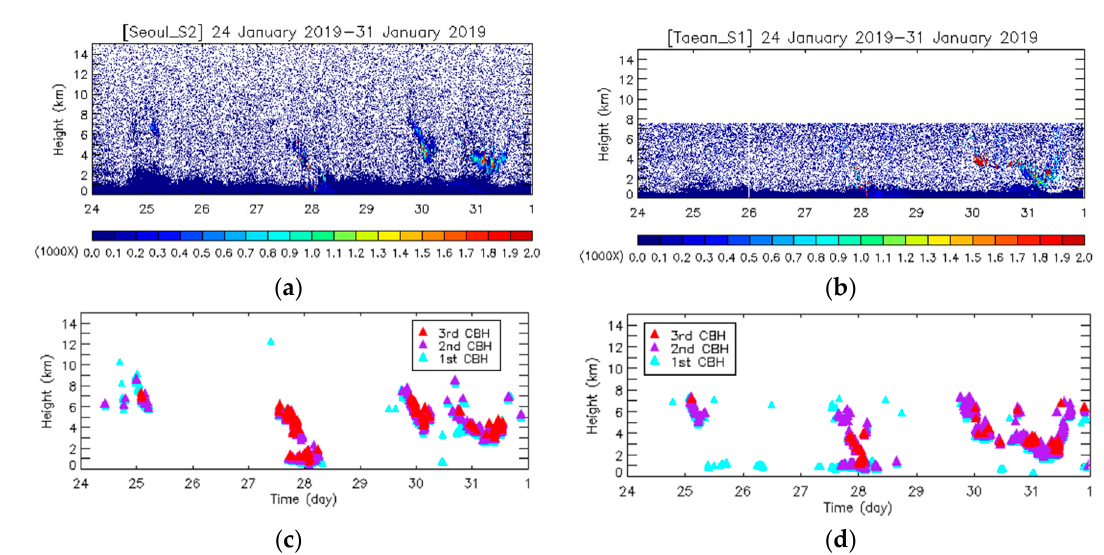
Figure 7. Examples of a winter case on 24–31 January 2019 at ( a , c ) Seoul (Seoul_S2 station), ( b,d ) Taean (Taean_S1 station); ( a , b ) backscatter profiles and ( c , d ) CBHs detected by ceilometer over Seoul detected by ceilometer over Seoul. The colorbar represents the intensity of backscatter signals. The cyan, purple, and red triangles indicate the 1st, 2nd, and 3rd CBHs,